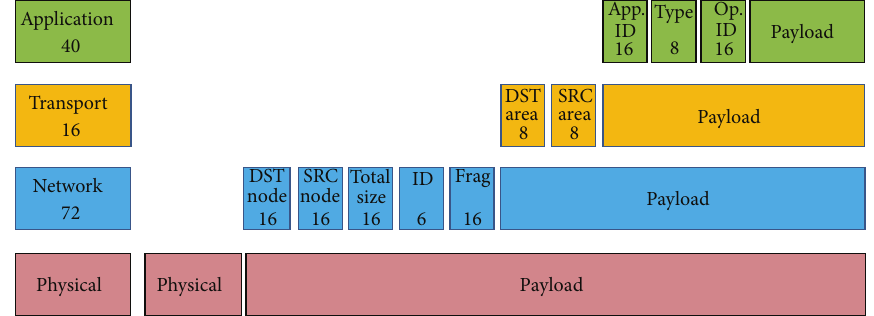
Figure 5: Computational node architecture.